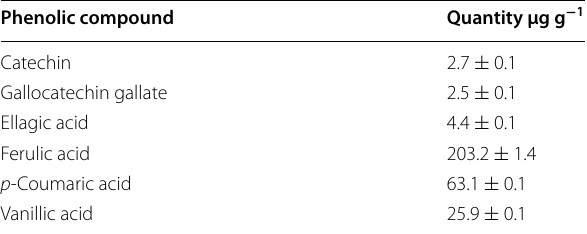
Table 3 Quantities of easily extractable phenolic compounds in rice bran